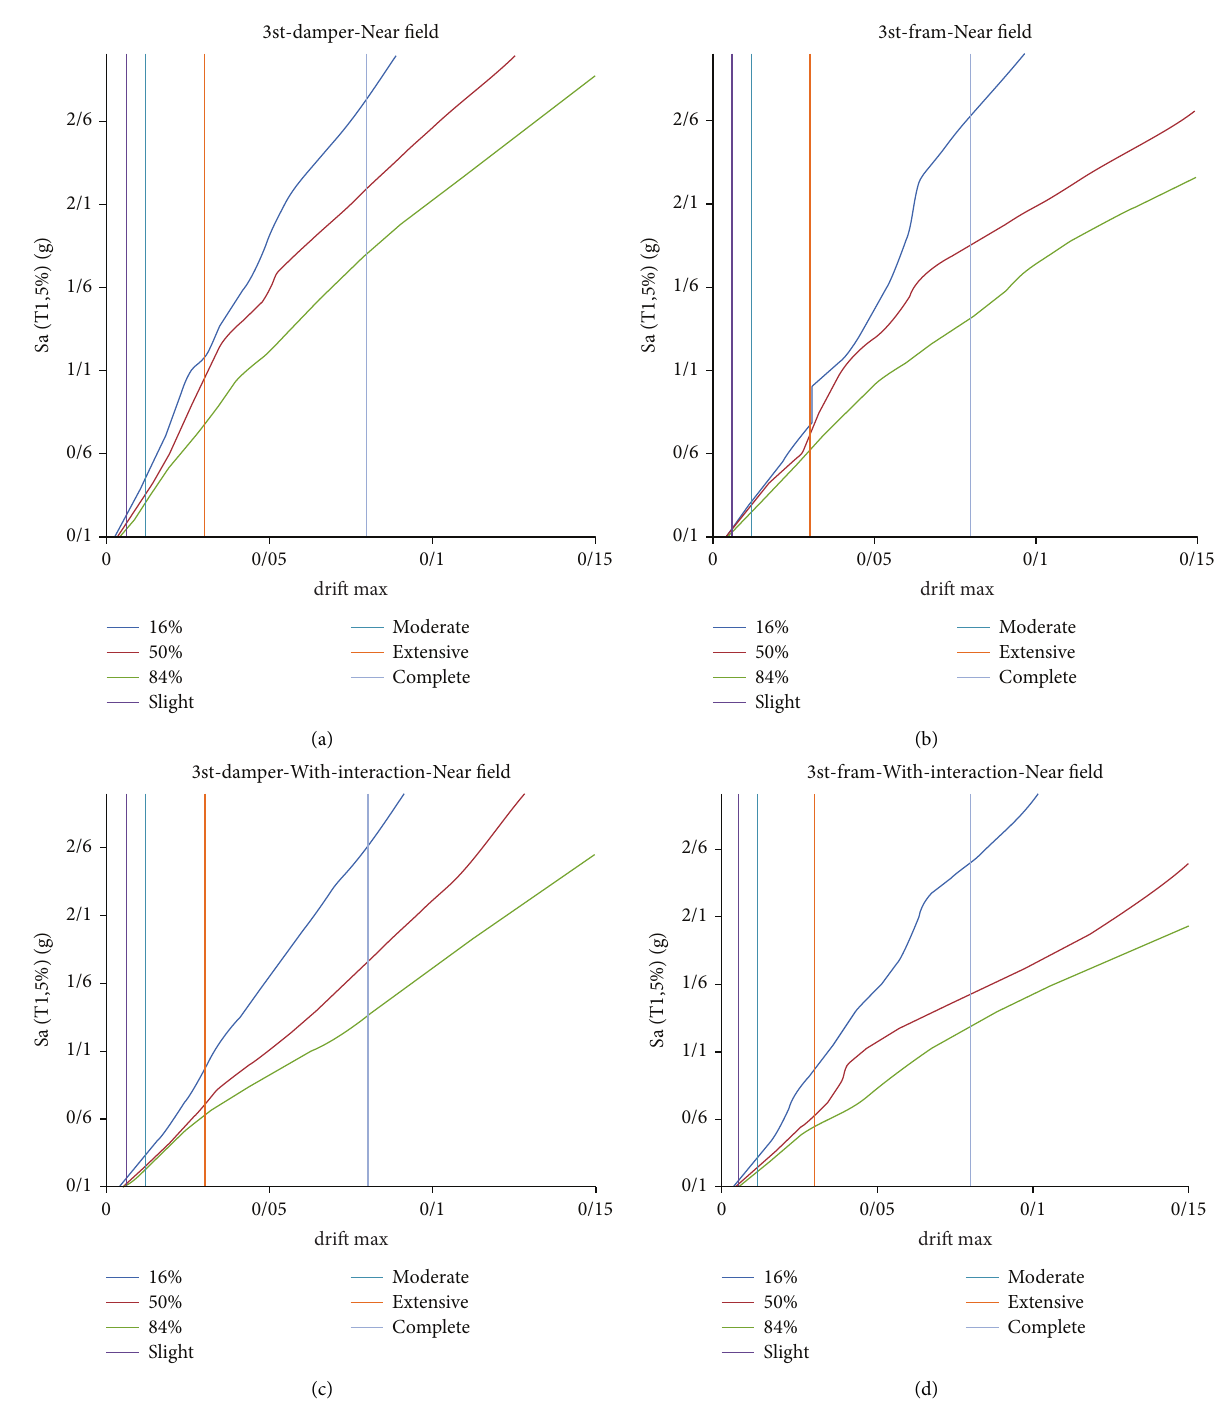
Figure 5: Summary of IDA curves for 16%, 50%, and 84% percentiles in 3-story Ordinary moment resisting frame affected by near-field earthquakes. Examined cases: (a) with damper without considering SSI; (b) without Damper and SSI effect; (c) with damper and considering SSI; (d) without damper but considering SSI